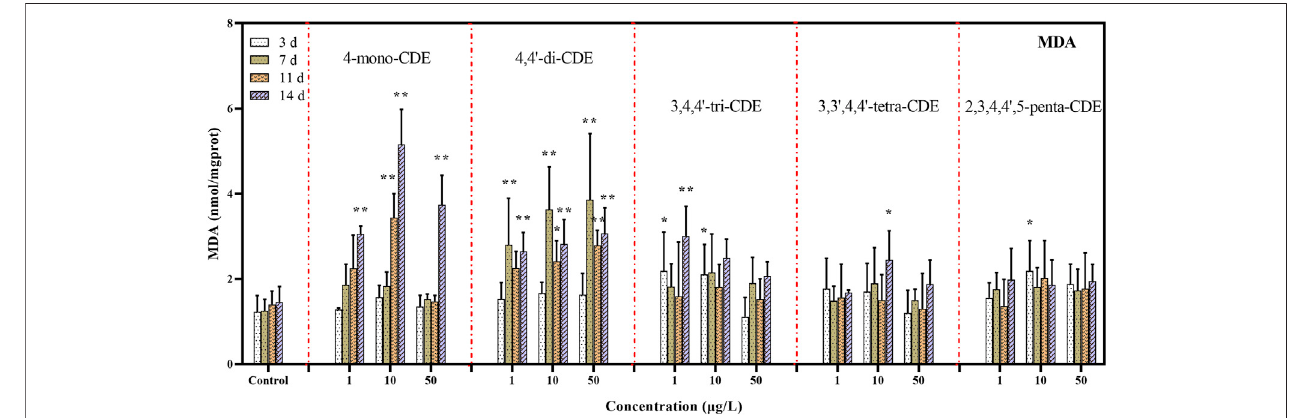
FIGURE 4 | The effect of PCDEs on the MDA levels in zebra fi sh liver.